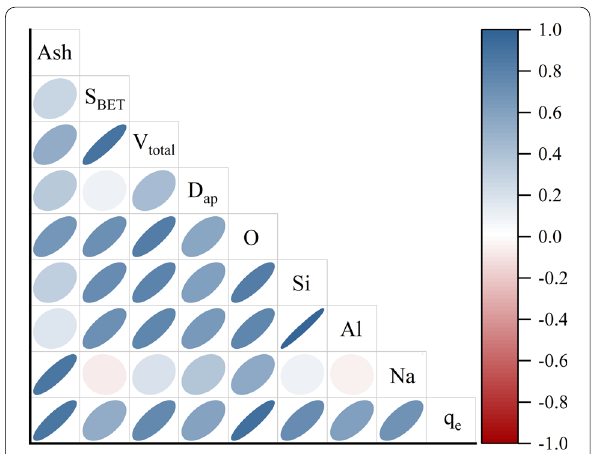
Fig. 5 Correlation of basic properties of BC or AFFA/BC with equilibrium adsorption capacity of Pb(II) (temperature 5; Pb(II) initial concentration ≈ time 24 =